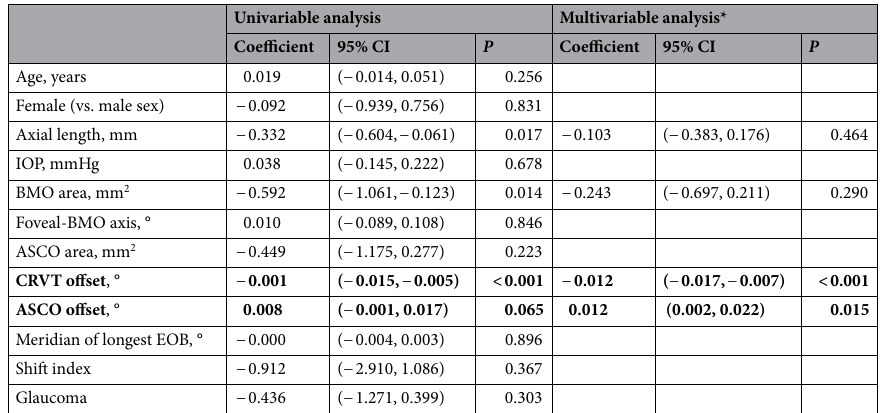
Table 2. Factors associated with offset ratio: central retinal vascular trunk (CRVT) offset divided by anterior scleral canal opening (ASCO) offset. Statistically significant values ( P < 0.05) are shown in bold. CI, Confidence interval; IOP, Intraocular pressure; BMO, Bruch’s membrane opening; ASCO, Anterior scleral canal opening; CRVT, Central retinal vascular trunk; EOB, Externally oblique border. *Variables with P < 0.10 in the univariable analysis were included in the subsequent multivariable analysis.